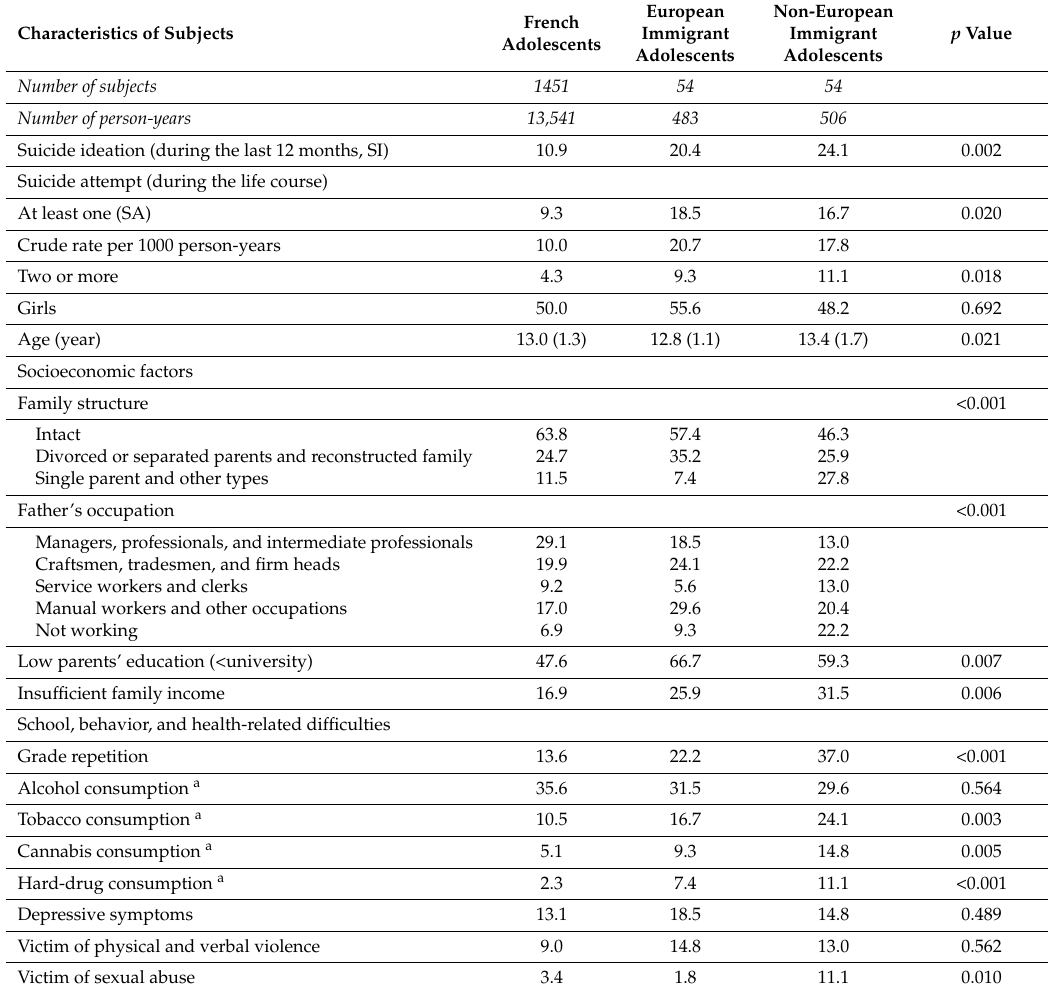
Table 2. Associations between nationality and various factors: % or mean (SD).